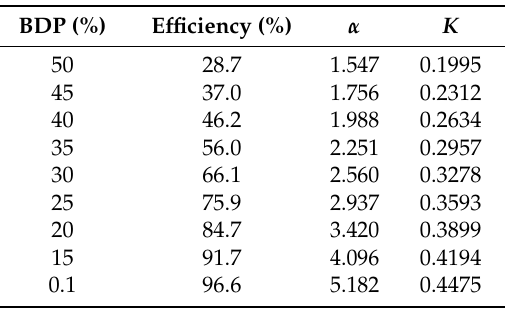
Table A1. Relative efficiency vs. breakdown